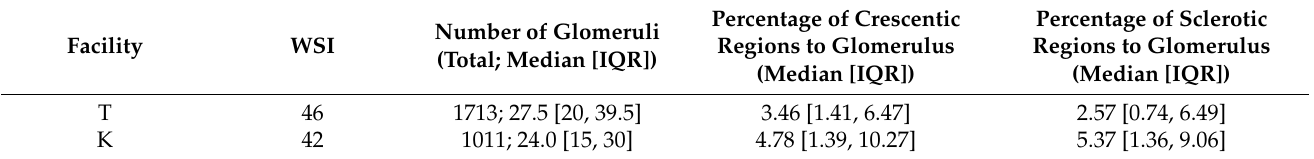
Table 3. Characteristics of the annotated WSI for glomerular segmentation. Figure 1. Example of a whole slide image (WSI) ( top row ). The bounding boxes of a glomerulus are shown as a rectangle with a yellow border in the second row. The glomerular images cropped by the bounding boxes are shown in the third row. The annotated images for the segmentation corre- sponding to the cropped glomeruli are shown in the bottom row. The examples in the ( bottom row ) (1) – (4) include cases with different percentages of sclerotic regions. (1) is an example of global scle- rosis, in which there is no glomerular tuft (red). (2) and (3) are examples without sclerosis, in which there is no sclerotic region (blue). (4) is an example of segmental sclerosis, in which the glomerular tuft (red) and sclerotic region (blue) are almost equal in area.